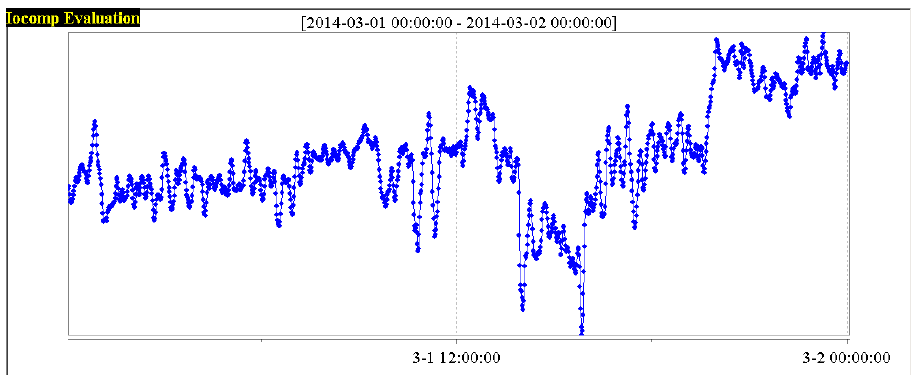
Figure 4. The flue gas temperature x 2 ( ◦ C) (1# boiler).